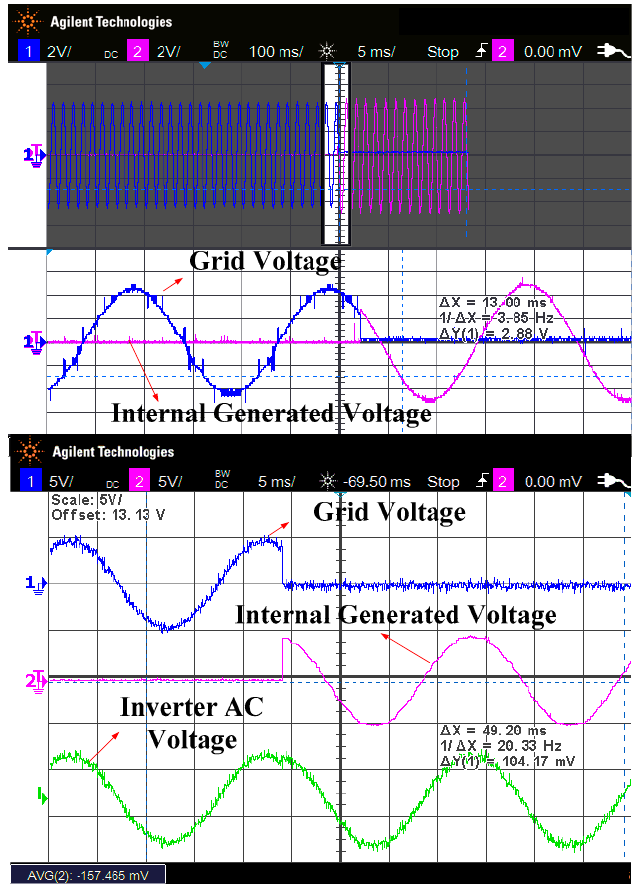
Figure 13. Grid voltage, internal oscillator voltage and inverter output voltage during a changeover in the mode of operation.